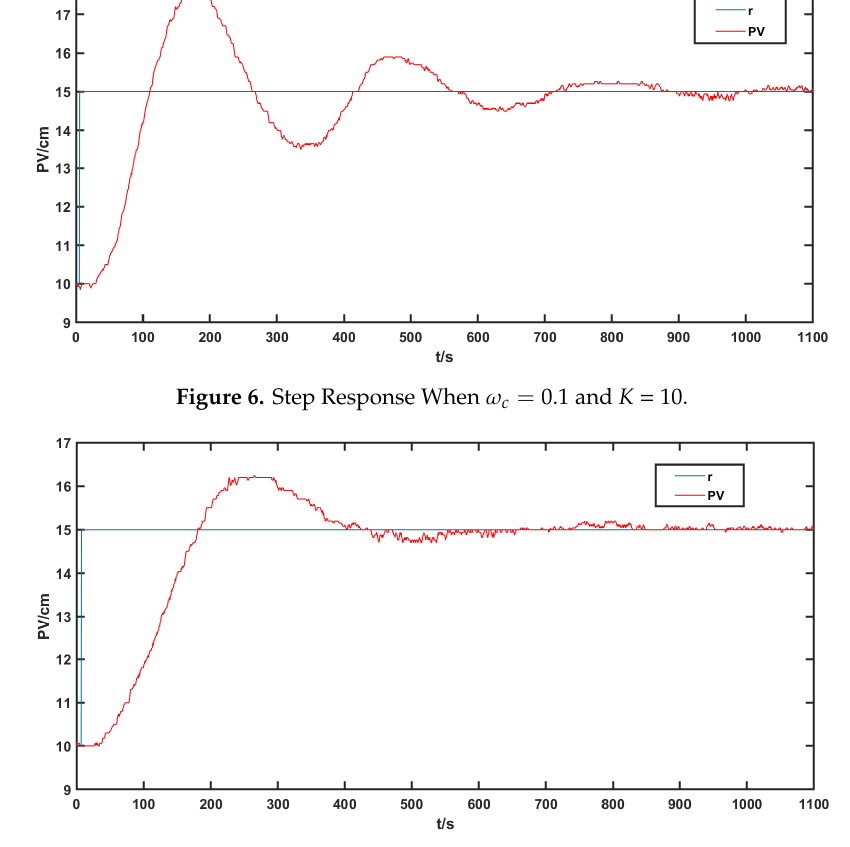
Figure 7. Step Response When 𝜔 (cid:3030) = 0.05 and 𝐾 = 10 .